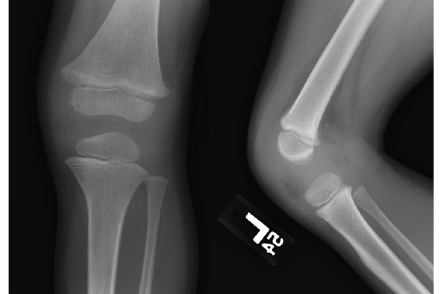
Figure 4: AP and lateral radiographic view of the left knee joint demonstrating joint e ff usion without presence of